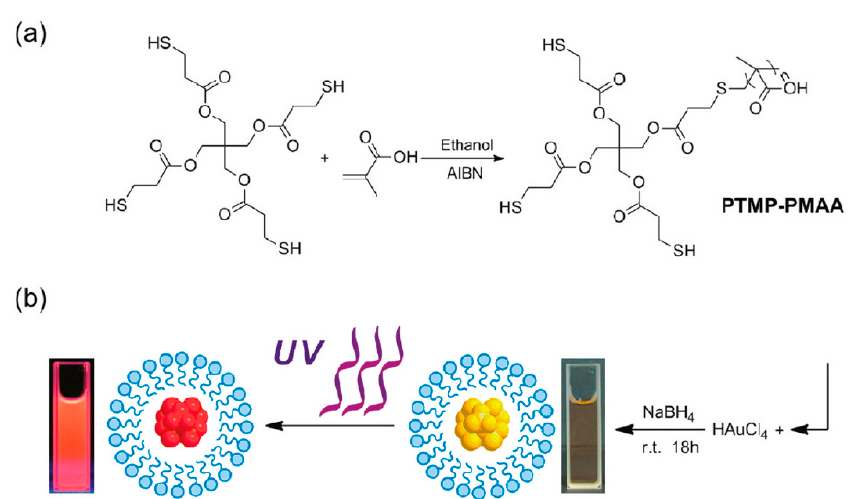
Figure 7. ( a ) Reaction scheme for the synthesis of thioether polymer ligand PTMP–PMAA; ( b ) Preparation of Au NCs stabilized by polymer ligands. Inserts are photographs of Au NCs’ aqueous solution under the irradiation of 365 nm ultraviolet light ( left, red fluorescence) and day light ( right , yellow color) [94].